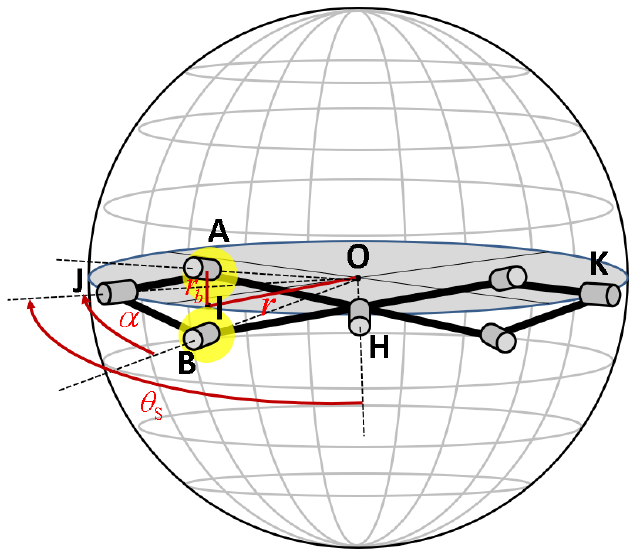
Figure 4. Maximum deployed status of the spherical scissor mechanism.